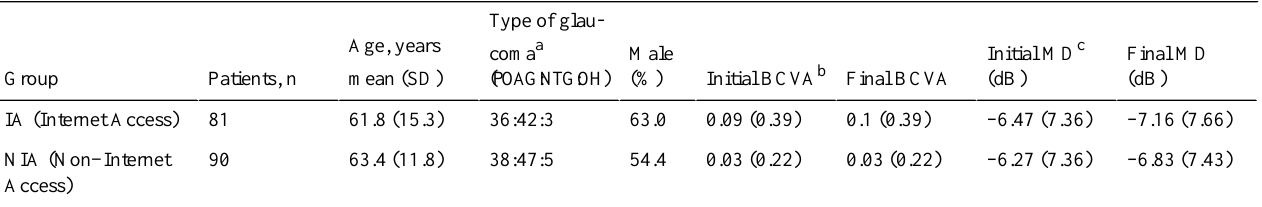
Table 2. Characteristics of completed patients (numbers in parentheses are standard